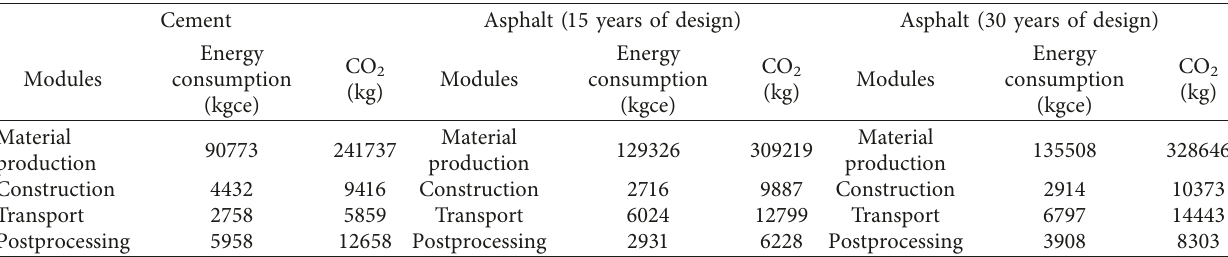
Table 5: Life-cycle inventories of the three pavement structures.